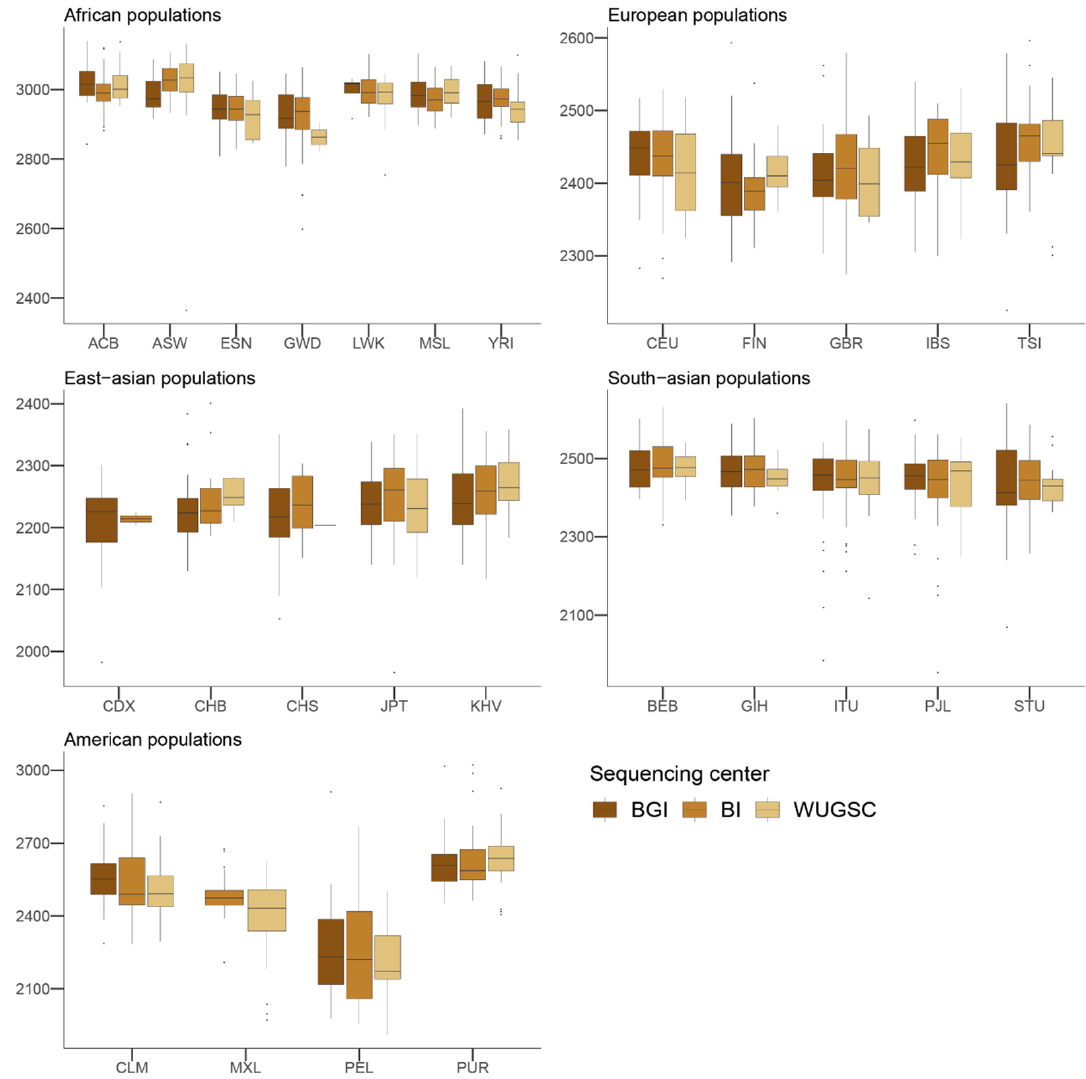
Figure 3. Number of benign variants by sequencing center across continental groups and populations. Each panel corresponds to a continental group. In the x -axis the name of the population is displayed; in the y -axis the number of benign SNVs per individual is displayed. Acronyms are showed in Supplementary Materials Table S1.